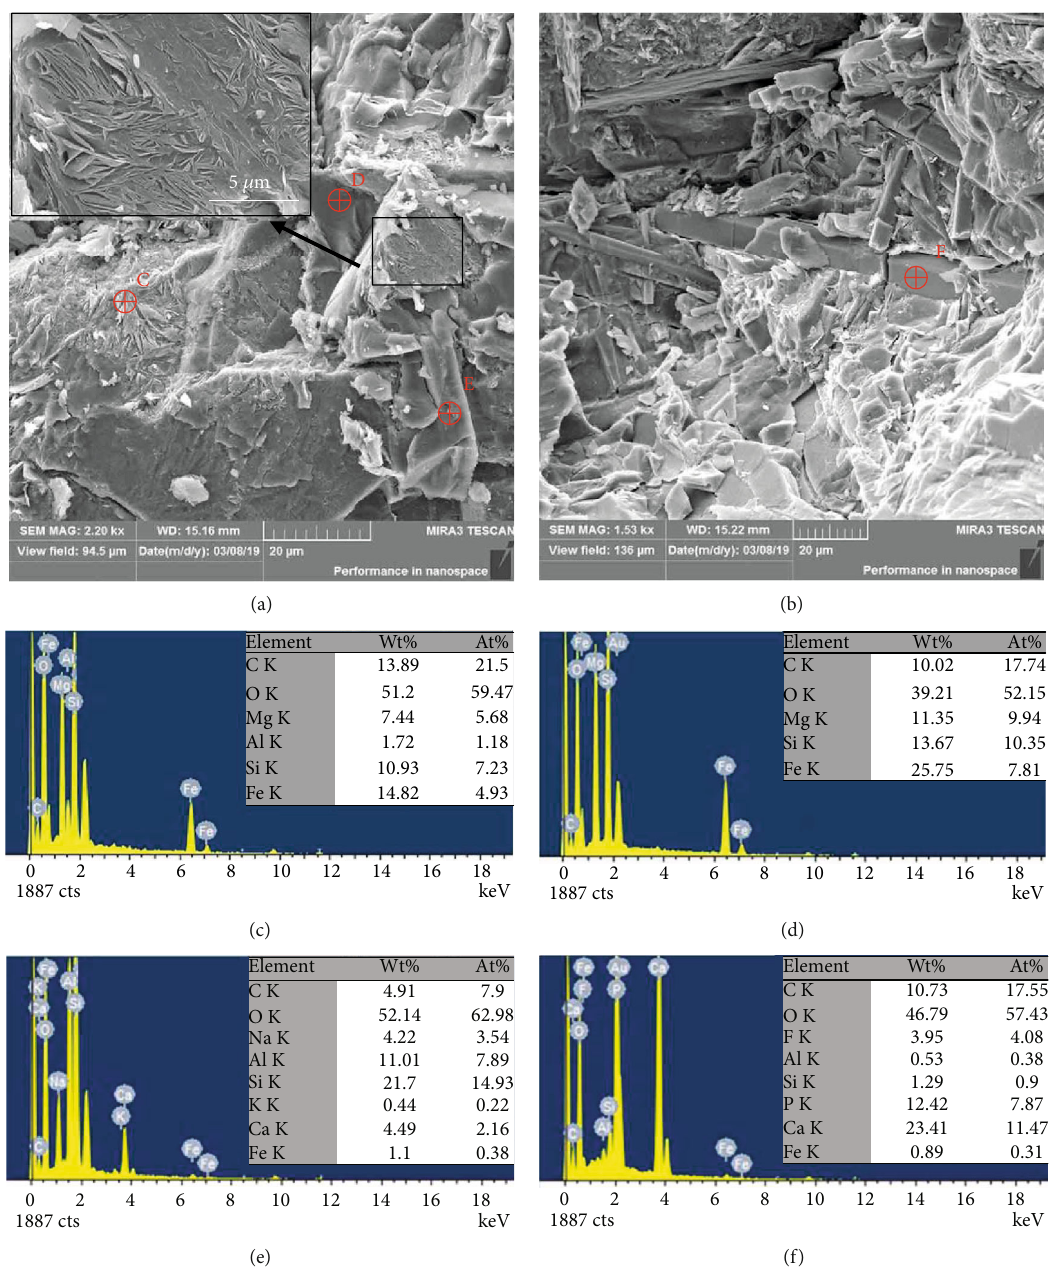
Figure 7: (a, b) SEM images of sample TS3 showing the EDS measurement points. (c – f) EDS patterns at the spots noted panels in (a) and